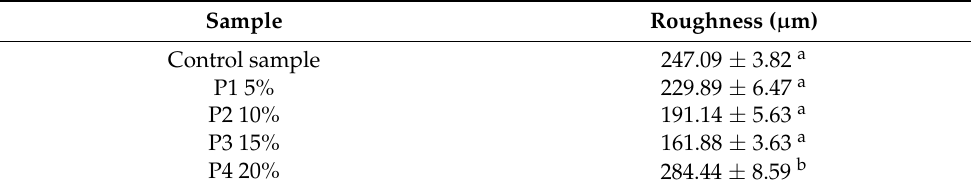
Table 9. Dry pasta